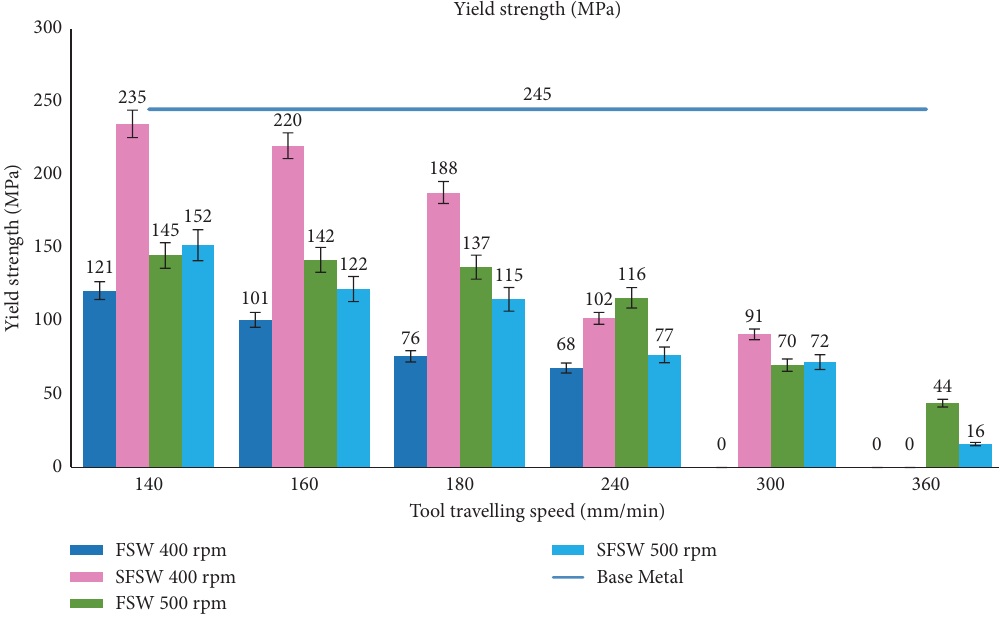
Figure 5: Yield strength of the welded